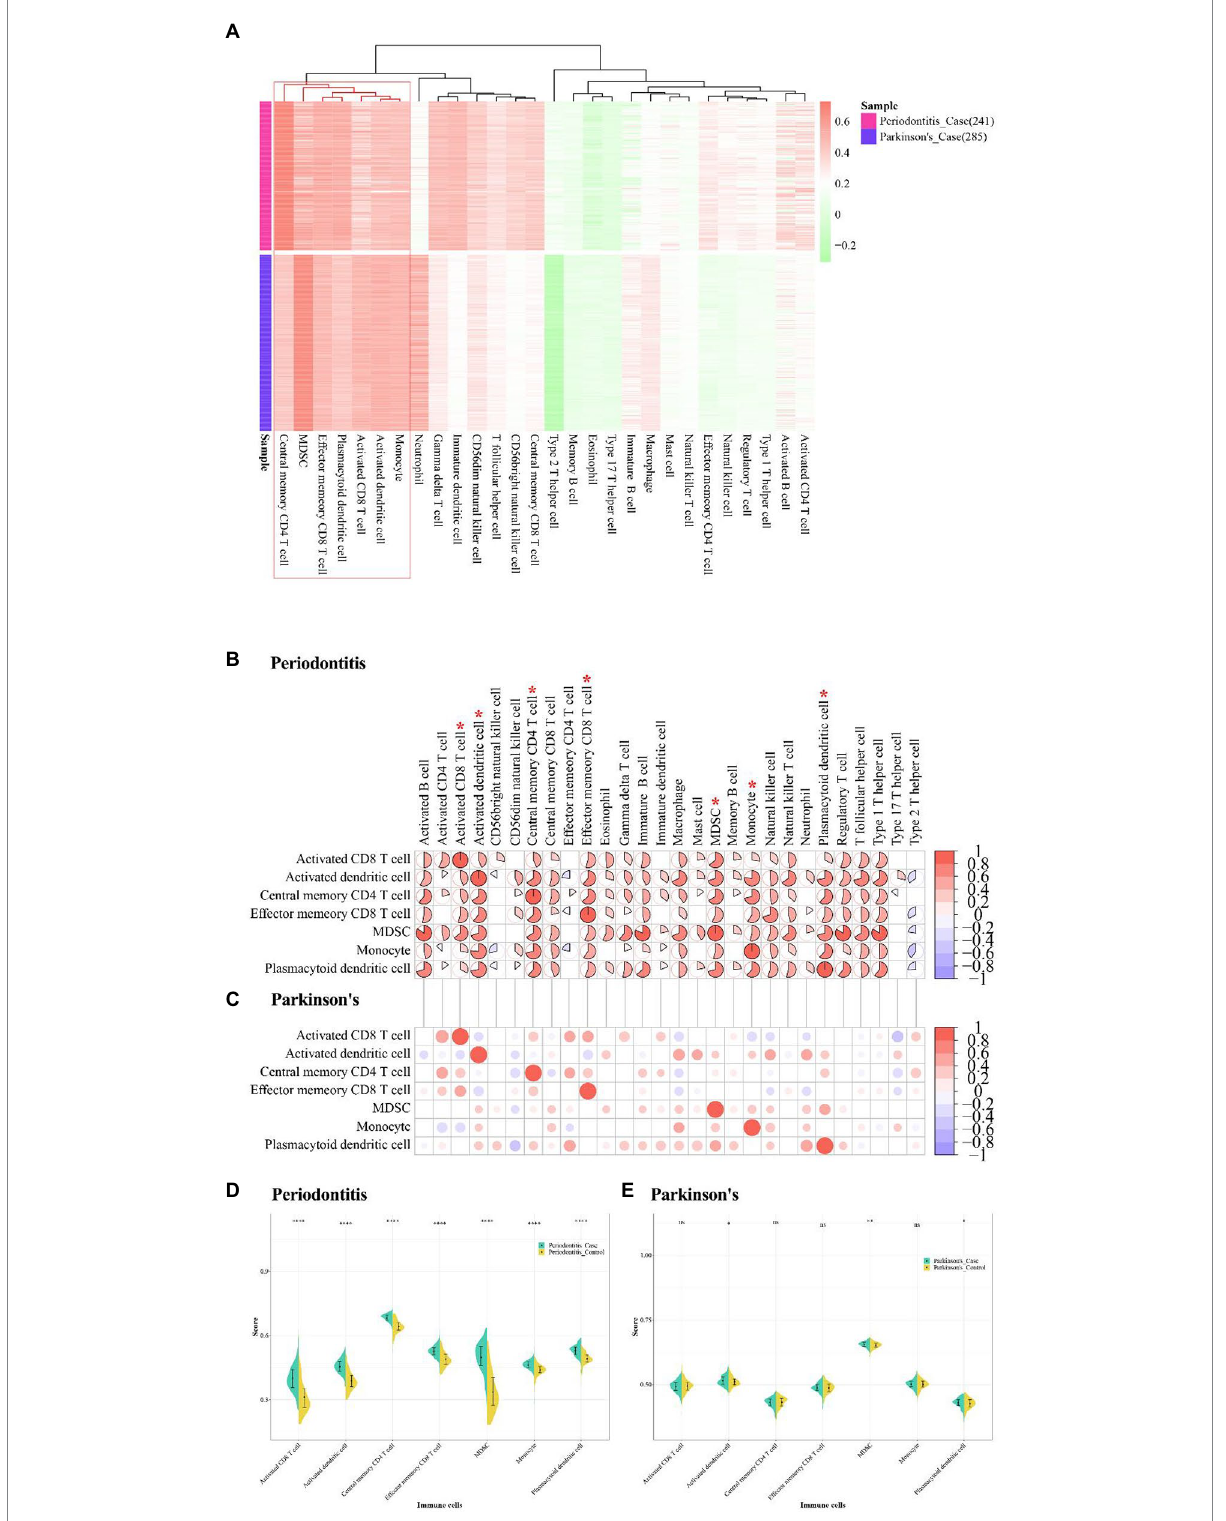
FIGURE 11 Immune infiltrative analysis of Periodontitis disease and Parkinson’s disease. (A) The abundance fraction of immune cells in disease samples of Periodontitis disease and Parkinson’s disease. (B,C) Correlation of higher abundance immune cells and other immune cells in Periodontitis disease and Parkinson’s disease. (D,E) Immune cell enrichment fractions in different sample types of Periodontitis and Parkinson’s